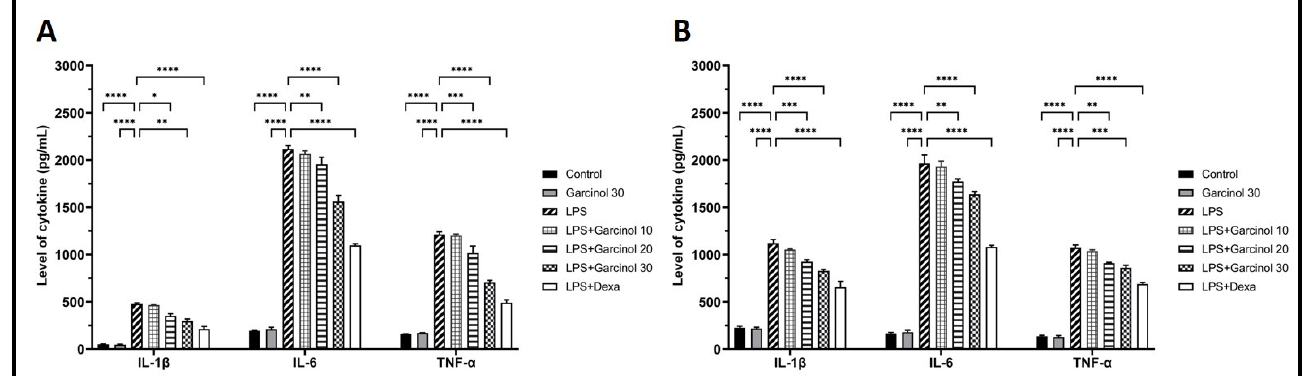
Figure 5. Effects of garcinol (10, 20, and 30 µ M) on the secretion of pro-inflammatory cytokines composed of TNF- α , IL-6, and IL-1 β were determined in THP-1 cells ( A ) and RAW264.7 cells ( B ) activated with LPS. The supernatants from the culture media of each group were determined for the secretion level of each cytokine using a sandwich ELISA test kit for each cytokine. The data are presented as the mean ± SD of duplicate examination in three independent experiments ( n = 6). For statistical analyses, One-way ANOVA and Dunne tt (cid:31)s test were used. * p < 0.05, ** p < 0.01, *** p < 0.001, **** p < 0.0001.